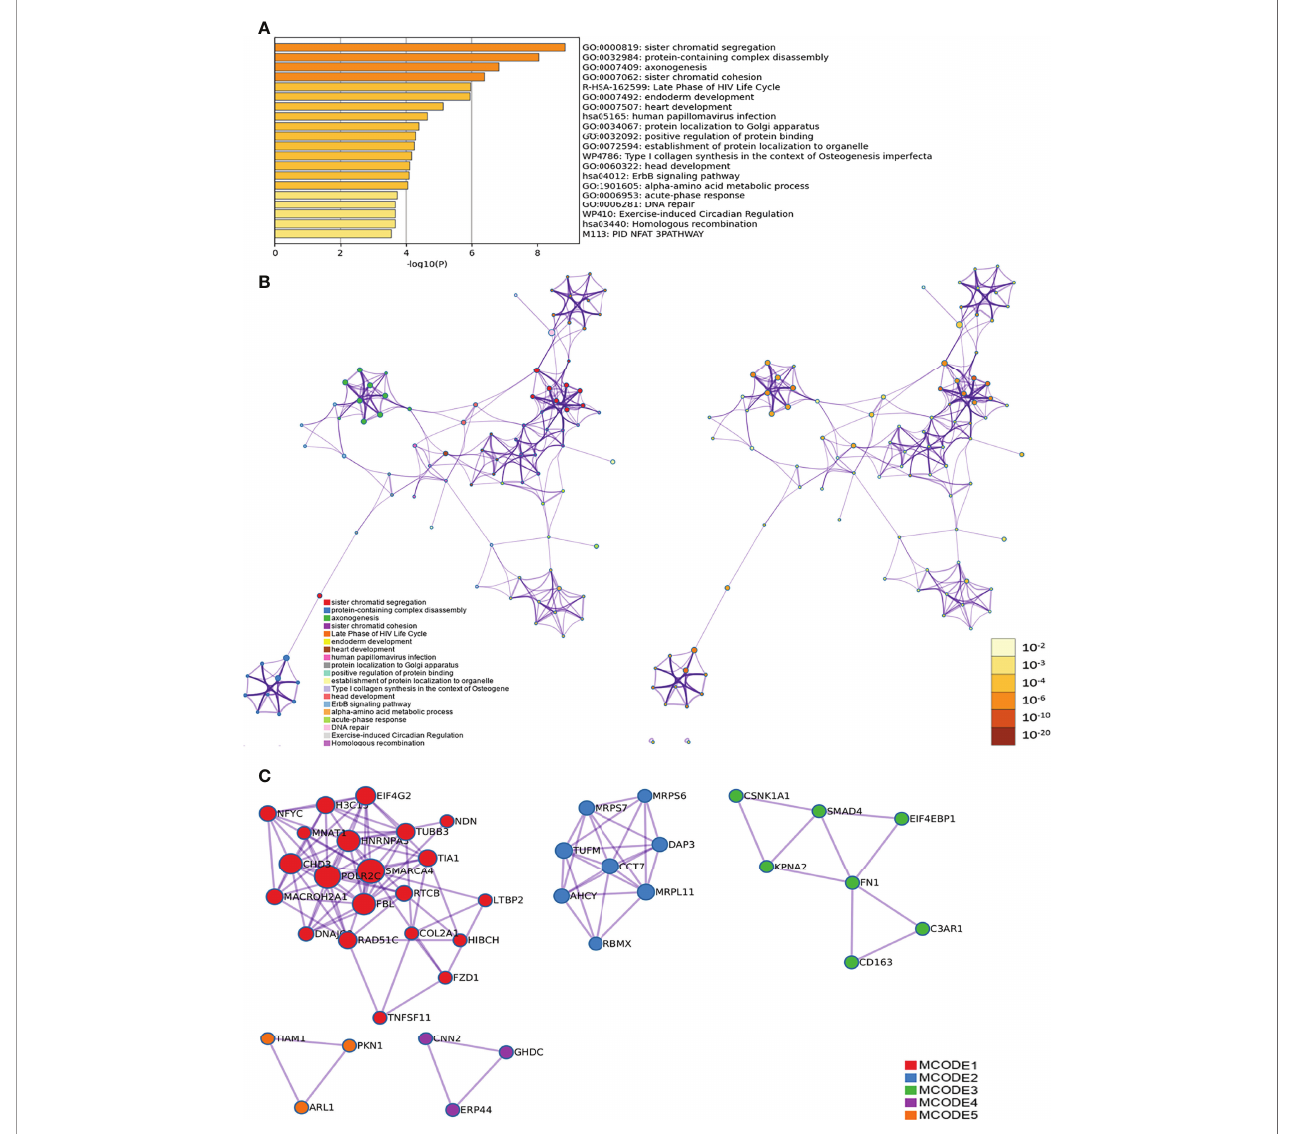
FIGURE 9 | Metascape results [ (A) Heatmap of top enrichment results; (B) PPI network colored by cluster and (C) PPI network colored by P